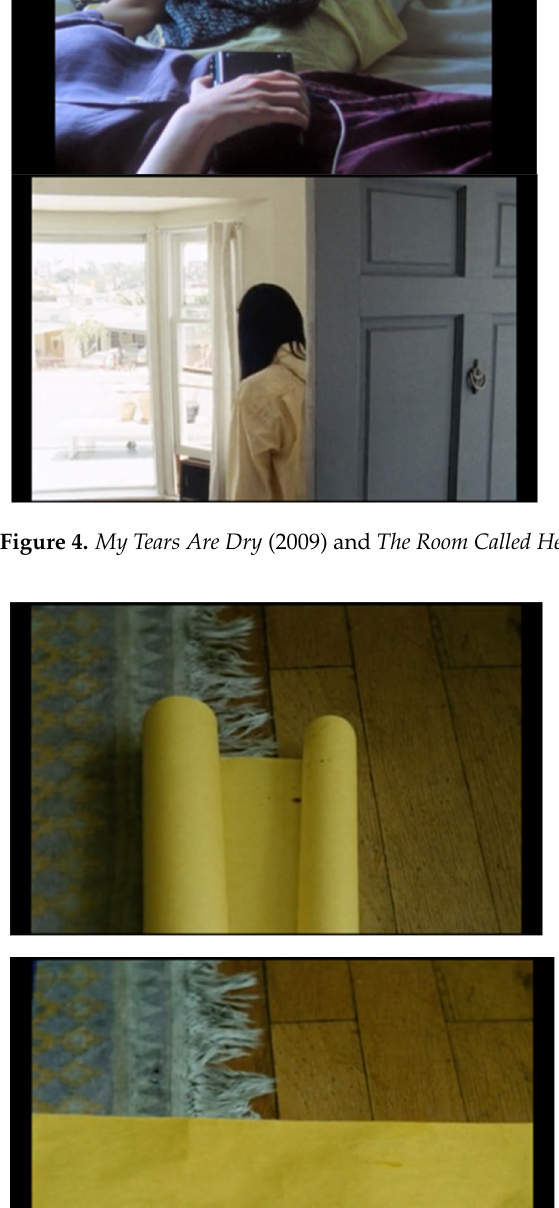
Figure 6. Live to Live (2015). Against a landscape with a canopy of clouds and a faint rainbow, a hand in the fore- ground of the frame holds something that looks like little lemons stuffed inside a larger one. In the same setting later on, a hand holds something that looks like a lemon wishing it were instead a banana (Figure 7). If lemons figure as things seen in the world, then lemon is repeatedly used as a way in which to talk about the world too. Lertxundi sees lemons and responds in lemons: in, for instance, lemon-coloured subtitles. Writing and reading, a woman wears a lemon-coloured shirt. Wearing the same shirt later on, she squeezes two lemons or objects resembling lemons (Figure 8). One is real, the other is fake: the real one bursts and the fake one remains intact. Between lemons fake, real and rare (the banana-like lemon and the involuted-looking lemon are examples of an unusual cit- rus fruit called a Buddha’s hand), Lertxundi collects images of lemons in such a way that spectators may find beauty in many of the world’s lemony forms. In a post-deconstructive meeting of absence and presence, some of these lemon-filled scenes that see lemons in the light of the world later withdraw from that light. Projected into a darkened room, a frame nested in a frame, these scenes from before become lemons in the dark, lemons of their own reflexive light (Figure 9). As much as lemons are pleasurably of the world, lemons